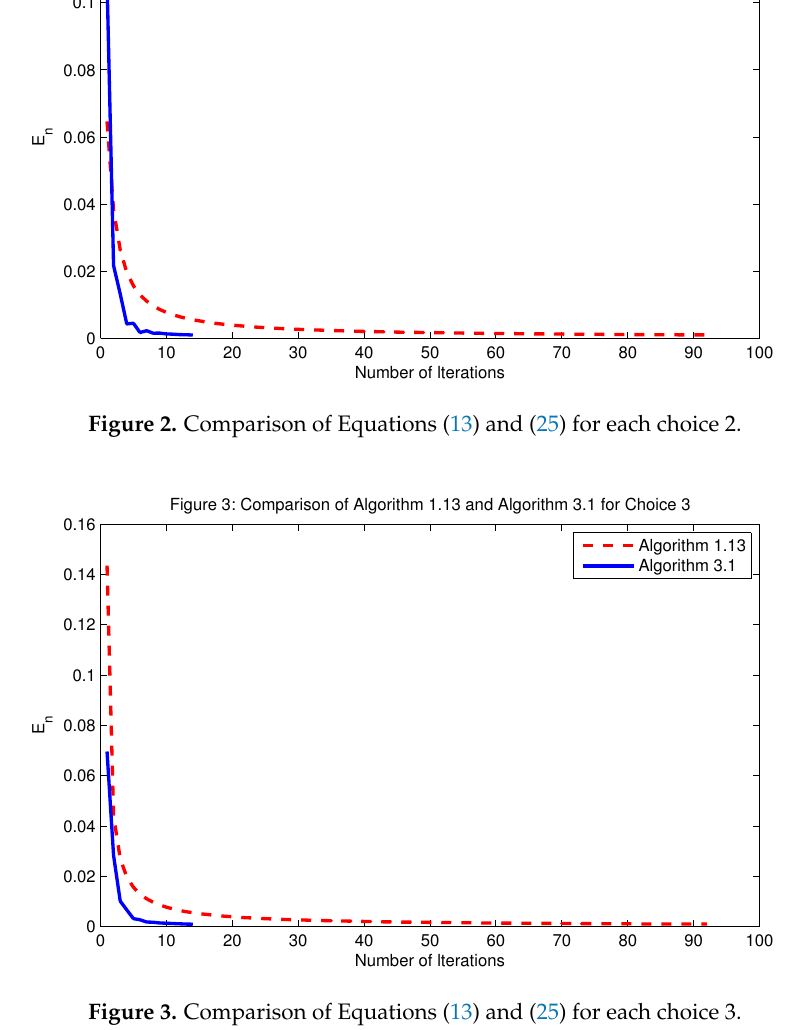
Algorithm 1.13 Algorithm 3.1